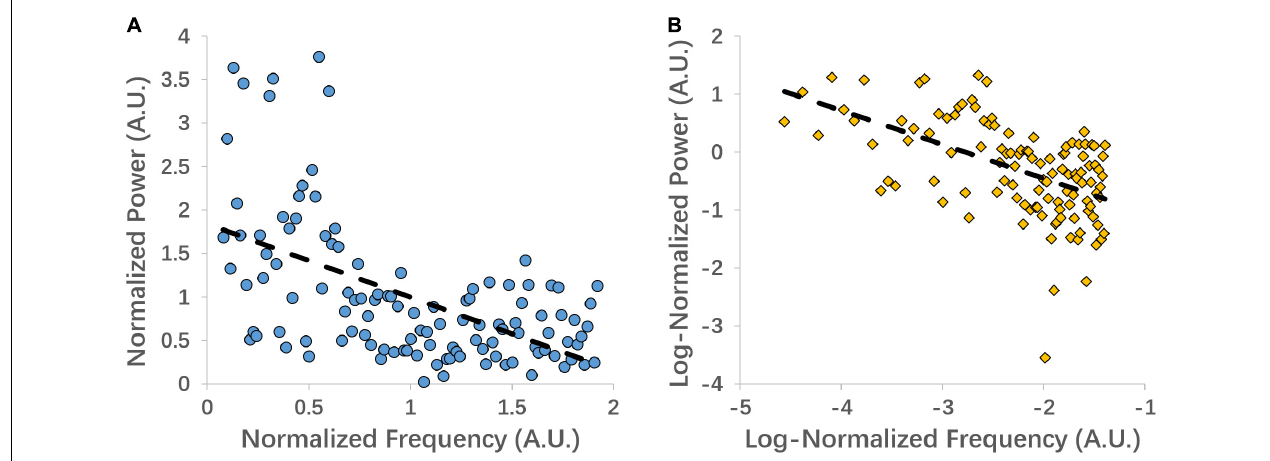
FIGURE 1 | An example of linear coefficient b (A) and power-law slope b’ (B) regression fitting from the left precentral gyrus of one